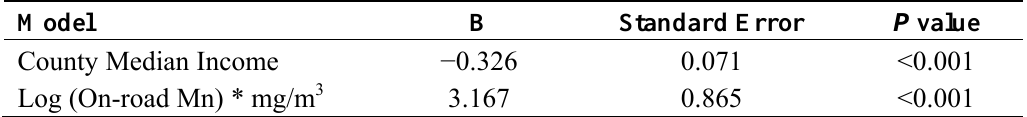
Table 2. Multivariable regression of county level correlates of chronic liver disease mortality in North Carolina Counties (n =